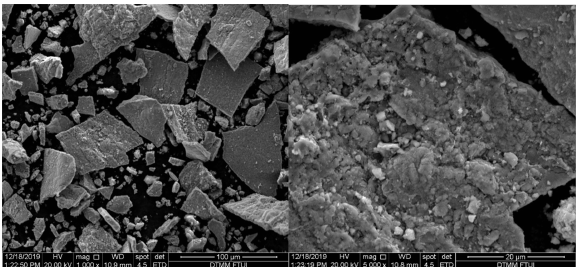
Fig. 1. SEM Images of RFW catalyst (magnification of 1000x (left) and 5000x